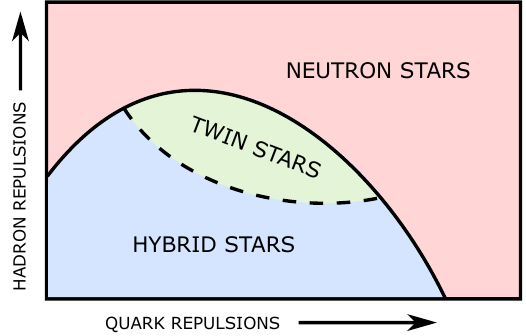
Figure 2. Summary of impact of repulsions in the hadron and in the quark phase on the M–R